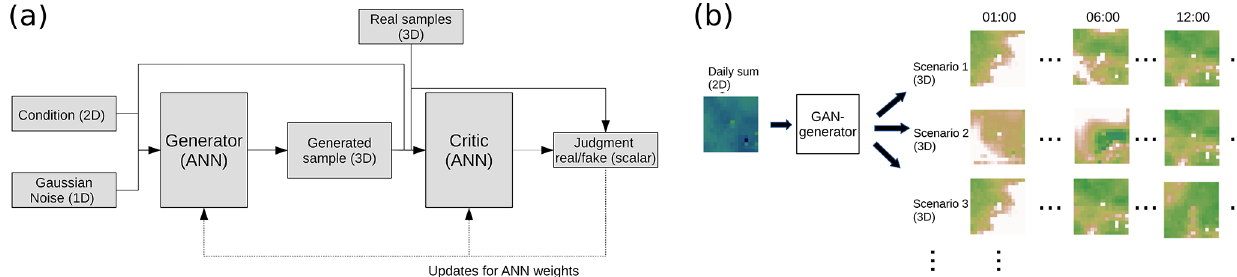
Figure 2. (a) Principle of a conditional GAN. (b) Sketch of the